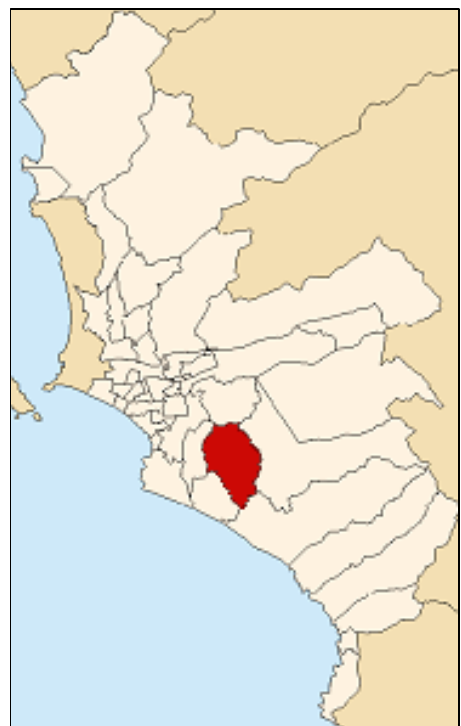
the district of Villa María del Triunfo-VMT (red) in Lima (light